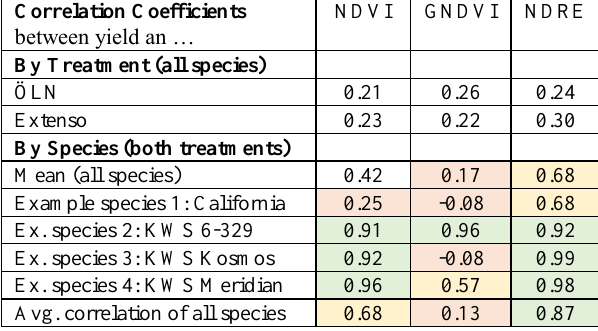
Table 5. Summary of correlation between crop yield